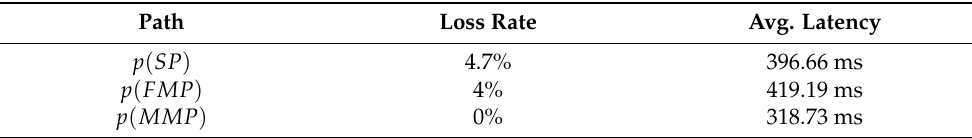
Table 1. Average latency and loss rate with FMP paths and MMP path during